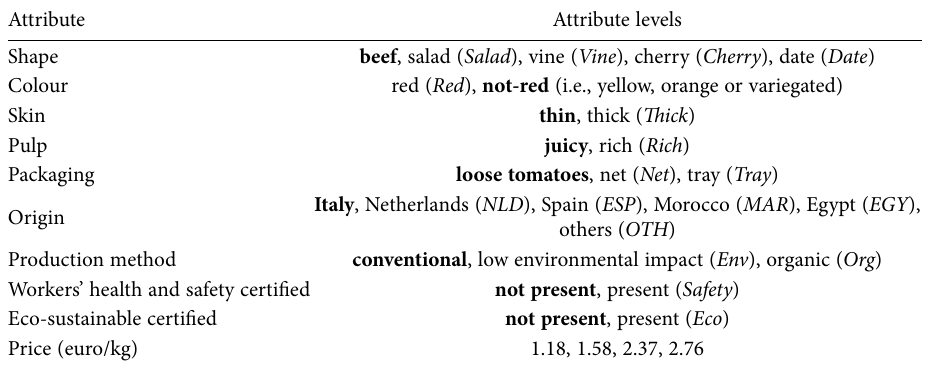
Table 1. Attributes and levels.